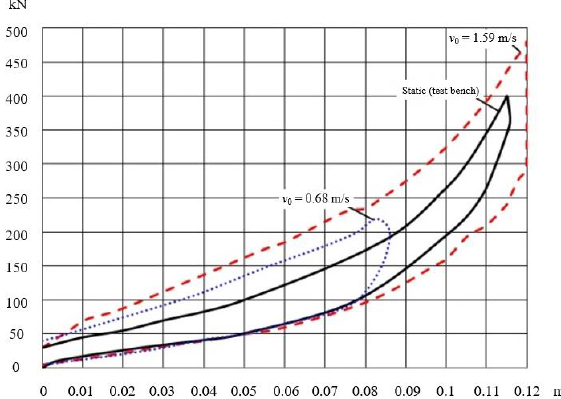
Figure 4. Dynamic force–deformation curve of the polymer pack for different impact speeds, — Static (test bench), - - v 0 = 1.59 m/s, ··· v 0 = 0.68